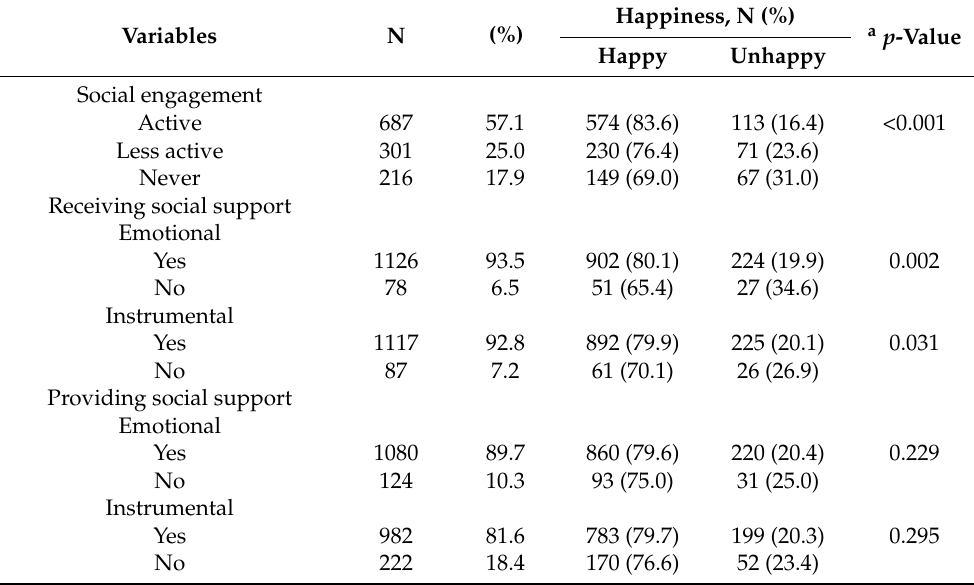
Table 3. Descriptive and bivariate analysis of social network associated with